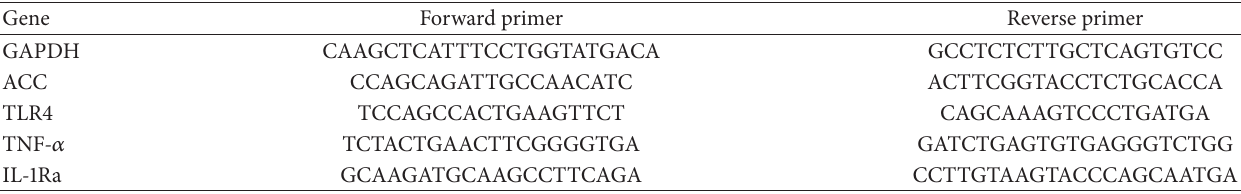
Table 1: Sequences of forward and reverse primers used for qRT-PCR.